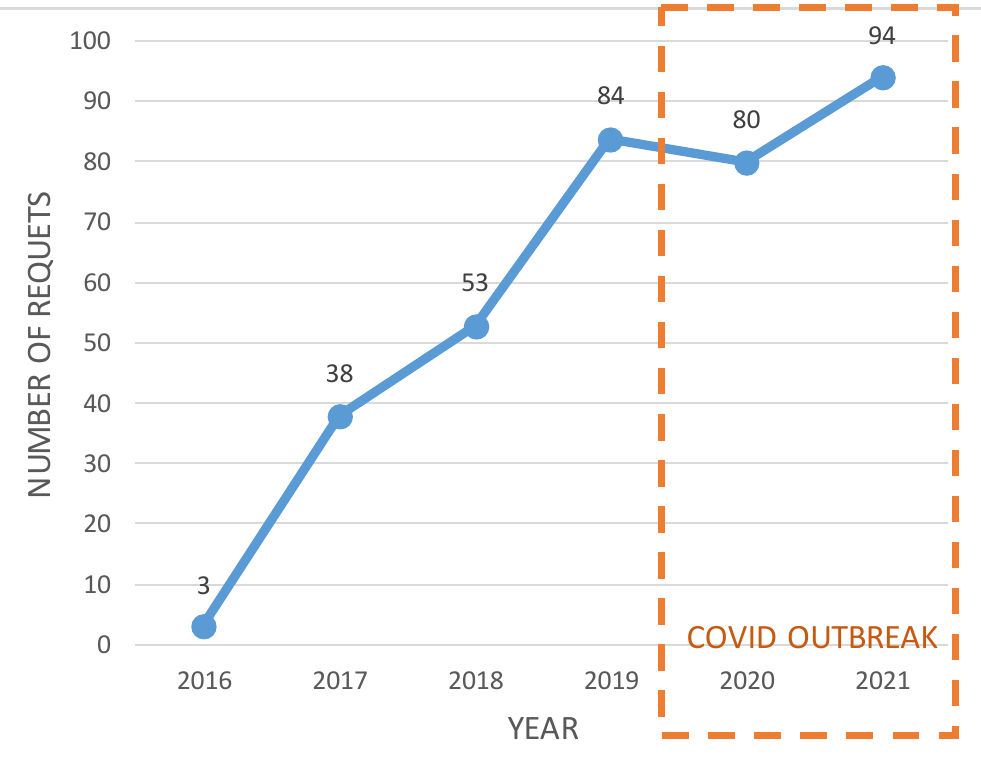
Figure 6. Evolution of requests registered on the intranet for 3D printing models at Cruces Hospital. It shows the requests received since the start-up of the service (September 2016) until the end of the present study (December 2021).